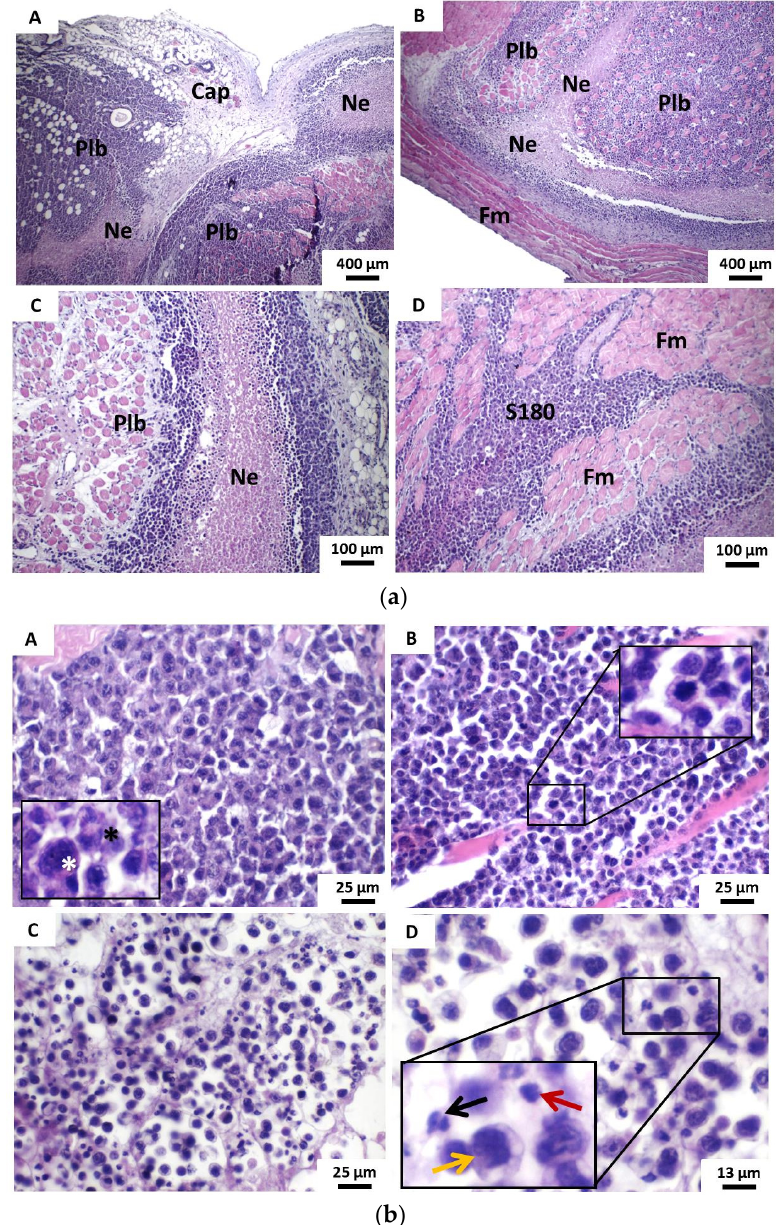
Figure 6. Photomicrographs of histological sections stained in HE show the main histopathological features of tumors developed in the 5-FU group from the implantation of S180 cells. ( a ) (A) The superficial area shows pseudocapsule and blocks of tumor cells separated by necrotic tissue trabecular, giving a pseudolobular aspect (40×). (B) Deep portion facing the hypodermis shows, in a similar way, the necrotic trabecular that separate blocks of tumor cells into pseudolobules; note the marked delimitation of the tumor by striated skeletal muscle fibers (40×). (C) Detail of the narrow bands of necrotic tissue (trabic) separating the pseudolobules (100 ×). (D) The central portion of the tumor shows tumor cells that invade bundles of muscle fibers, separating them into relatively well-preserved blocks (100×). Caption: Cap—superficial pseudocapsule; Coagulative necrosis; Plb—pseudolobules; Fm—skeletal striated muscle fibers; S180—viable sarcoma 180 tumor cells and ( b ) (A) Tumor cells showing mild to moderate atypia, with cells sometimes showing nuclei of chromatin, sometimes dense (white asterisk), sometimes dispersed (black asterisk) (400 ×, detail in 800 ×). (B) Figure of typical mitosis in prophase (400×, detail in 800×). (C,D) Intense inflammatory infiltrate and interstitial edema in the middle of the tumor parenchyma (400 × and 800 ×, respectively; details in 1500 ×). Legend: Yellow arrow—Tumor cell; Black arrow—neutrophil polymorphonuclear; Red arrow—lymphocyte. POH/ β -CD 50 mg/Kg group presented histological characteristics similar to those evidenced in the 5-FU group, expressed by an architectural arrangement of tumor cells also in irregular pseudolobules, now separated by edematous fibrous connective tissue and rich in inflammatory cells, sometimes separated by necrotic trabeculae tissue. It was observed that the proportion of areas of coagulative necrosis shown in this group was higher than in the 5-FU group (Figure 7a). The invasion pattern of striated skeletal muscle tissue and subcutaneous adipose panicle by tumor cells was also similar to the 5-FU group, with tissue dissociation in dense and compact blocks of muscle fibers and fat cells. Mitotic activity was still marked but seldom atypical mitosis (Figure 7b). POH/ β -CD 100 and 200 mg/Kg groups presented similar histological characteristics, characterized by more dense neoplastic proliferation, without lobulation or apparent pseudolobulation, with areas of extensive necrosis both within the tumor mass and in the marginal areas. The inflammatory reaction was limited to tumor margins and perinecrotic areas. The tumoral boundaries were shown to be irregular and strong dissociation and destruction of striated skeletal muscle fibers were observed. Besides, mitotic activity was expressive but with rare atypical (Figure 8). The degree of cytological atypia proved to be highly variable between the various tumors, sometimes milder and sometimes more